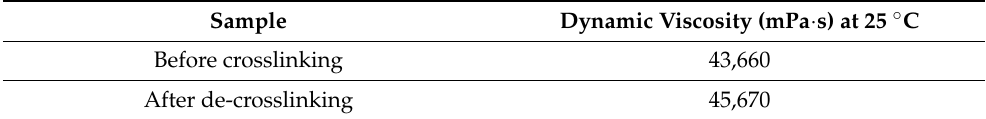
Table 1. Dynamic viscosity of crosslinking formulation and de-crosslinked material.